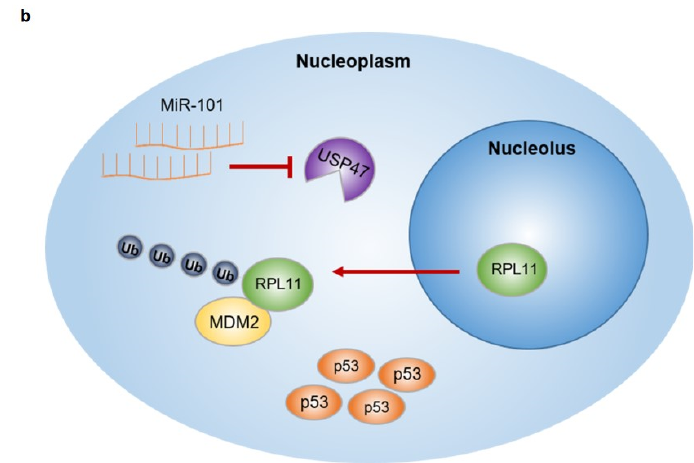
Figure 8. Schematic models for miR-101-3p function in lung cancer cells. ( a ) In cancer cells, increased USP47 deubiquitinates RPL11 and places it in the nucleolus. As a result, free-MDM2 can ubiquitinate p53 and induce its proteasomal degradation, which in turn promotes cell proliferation. ( b ) When miR-101-3p is overexpressed, USP47 levels are reduced by miR-101-3p and the ubiquitinated RPL11 shifts to the nucleoplasm, binds to MDM2, and inhibits p53 degradation by MDM2. Supplementary Materials: The following are available online at https://www.mdpi.com/article/ 10.3390/cancers14040964/s1, File S1: Original images of the western blot, Figure S1: Transfection efficiency of miR-101-3p mimic into the cells, Figure S2: The function of miR-101-3p dependent on p53, Figure S3: MiR-101-3p directly targets the USP47 gene, Figure S4: MiR-101-3p inhibits cell proliferation by targeting USP47 in H1650 cells, Figure S5: p53 protein stability is maintained by miR-101-3p, Figure S6: RPL11 ubiquitination is reduced by USP47 knockdown, Figure S7: The abundance of miR-101-3p in lung cancer cell